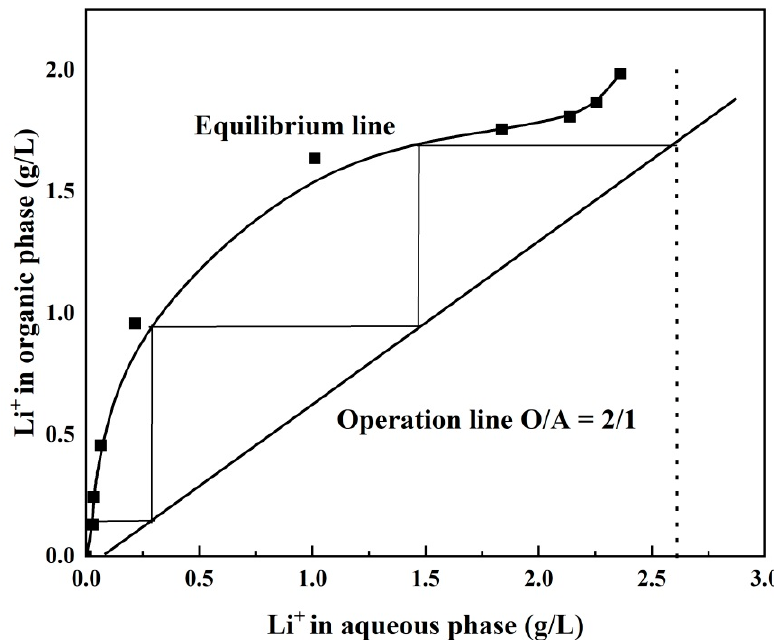
Figure 5. McCabe–Thiele graphical method to determine the theoretical